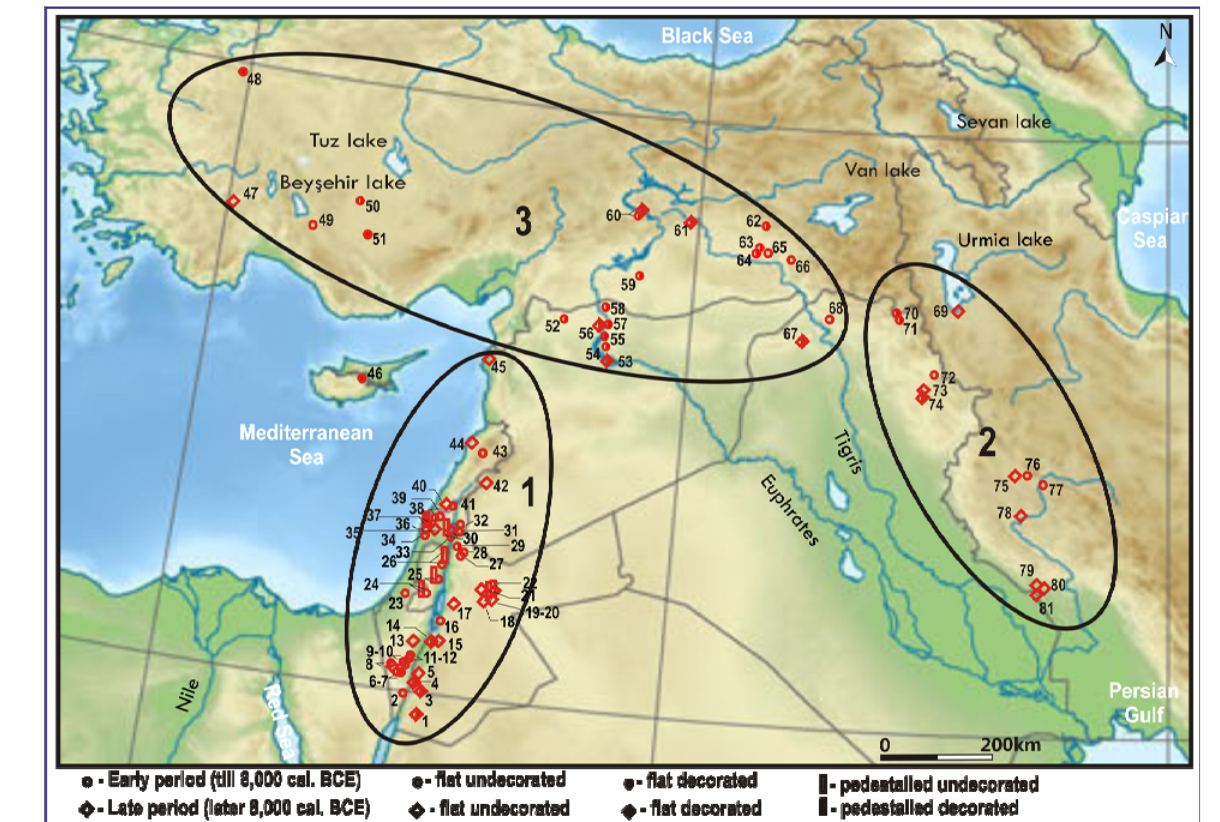
Figure 1. Distribution of grooved shaft straighteners in south-western Asia. (Relief_Map_of_Middle_East, Wikimedia Commons).1: the Levant; 2: the Zagros Mountains: 3: Central Anatolia & Upper Mesopotamia. 1-Ain Abu Nekheileh, 2-Negev, site 83, 3-Basta, 4-Baaja, 5-Saqarat Masad 1, 6-Shluhat Harif, 7-Ramat Harif, 8-Abu Salem, 9-Shluhat Romam, 10-Romam, 11-Maaleh Ramon West, 12-Maaleh Ramon East, 13-Nahal Divshon, 14-Wadi Fainan 328, 15-Wadi Badda, 16-Zahrat adh-Drha، 2, 17-Es-Siffiya, 18-Azraq 31, 19-Jilat 32, 20-Jilat 25, 21-Jilat 13, 22-Jilat 7 , 23-Hatula, 24-El-Khiam, 25-Jericho, 26-Netiv Hagdud, 27-Beidha, 28-Shagaret M’siad, 29-Wadi Hammeh 27, 30-Munhata, 31-Sha'ar Hagolan, 32-Mudjahiya, 33-‘Erq el-Ahmar, 34-Mugharet el-Kebarah, 35-Raqefet Cave, 36-el-Wad (Wady el-Mughara), 37-Nahal Oren, 38-Hayonim Cave, layer B; Hayonim Terrace, 39-Me'arot Yonim , 40-Kfar HaHoresh, 41-Ain Mallaha (Mallaha, Eynan) , 42-Ramad , 43-Saaïdé II, 44-Byblos, 45-Ras Shamra, 46-Ayia Varvara Asprokremnos, 47-Hacilar II, VI, 48-Demirci, 49-Suberde, 50-Boncuklu, 51-Pınarbaşı, 52-Qaramel, 53-Abu Hureyra, 54-Mureybet III, 55-Sheikh Nassan , 56-Halula, 57-Jerf el Ahmar, 58-Dja’de, 59-Göbekli , 60-Cafer , 61-Çayönü, 62-Hallan Çemi, 63-Demirköy, 64-Körtik Tepe, 65-Sumaki Höyük, 66-Gusir Höyük, 67-Kül , 68-Nemrik, 69-Hajji Firuz, 70-Zawi Chemi Shanidar , 71-Shanidar Cave, 72-Zarzi, 73-Jarmo, 74-Karim Shahir, 75-Sarab, 76-Tepe Asiab, 77-Ganj Dareh, 78-Guran, 79-Choga Sefid, 80-Sabz low., 81-Ali